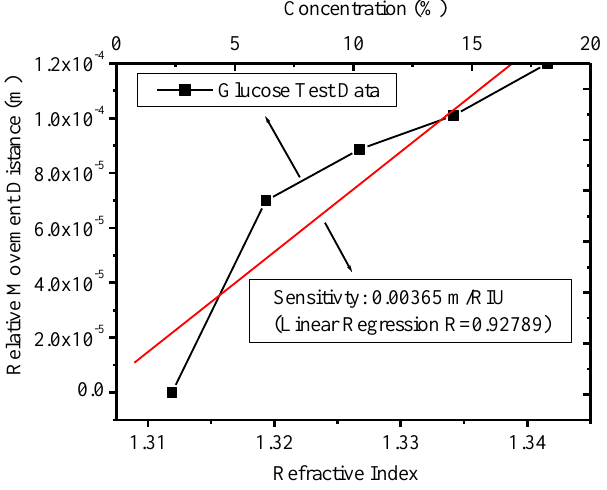
Figure 12. The sensitivity from the refractive index and relative movement distance in TM